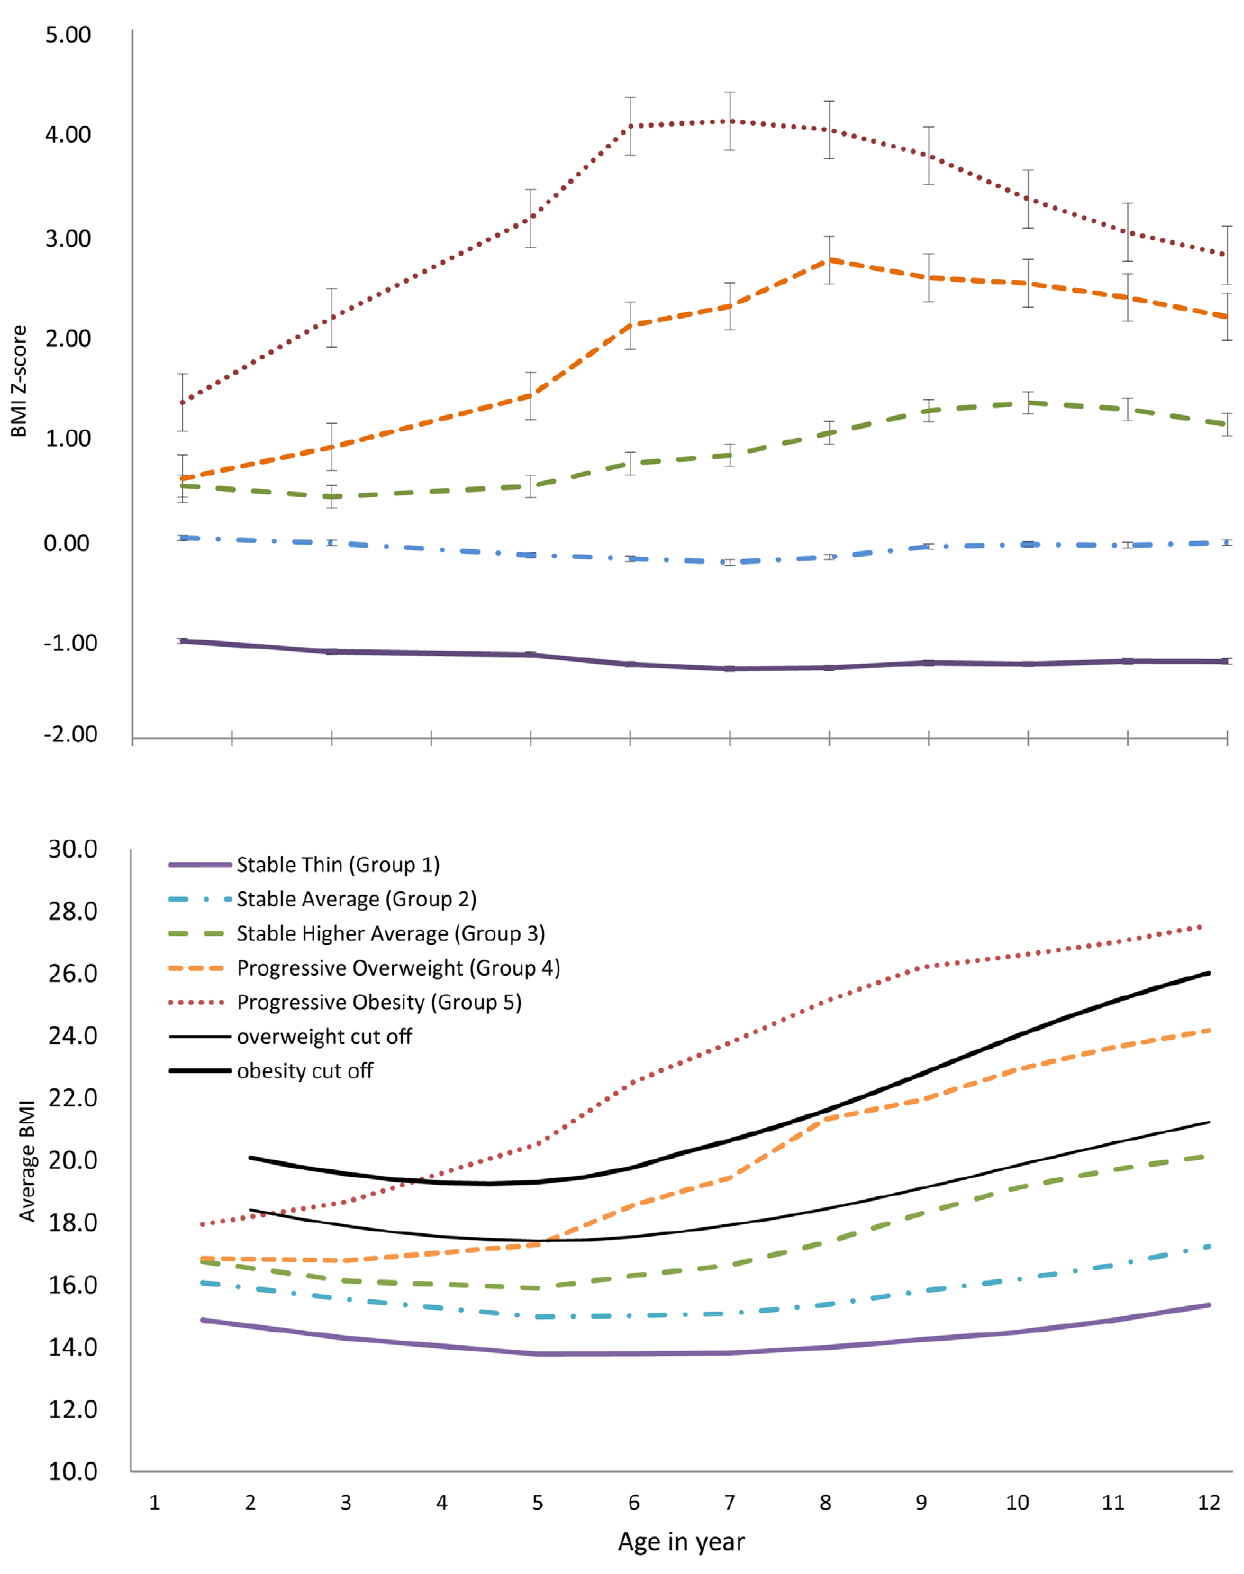
Figure 1. Trajectories of Body mass index (BMI) and the average BMI of boys aged 1.5 to 12 years in Koshu City, Japan, 1991–1998. Error bars indicate the standard error of the mean for each observed group. Group 1, ‘‘stable thin’’; Group 2, ‘‘stable average’’; Group 3, ‘‘stable high average’’; Group 4, ‘‘progressive overweight’’; Group 5, ‘‘progressive obesity.’’